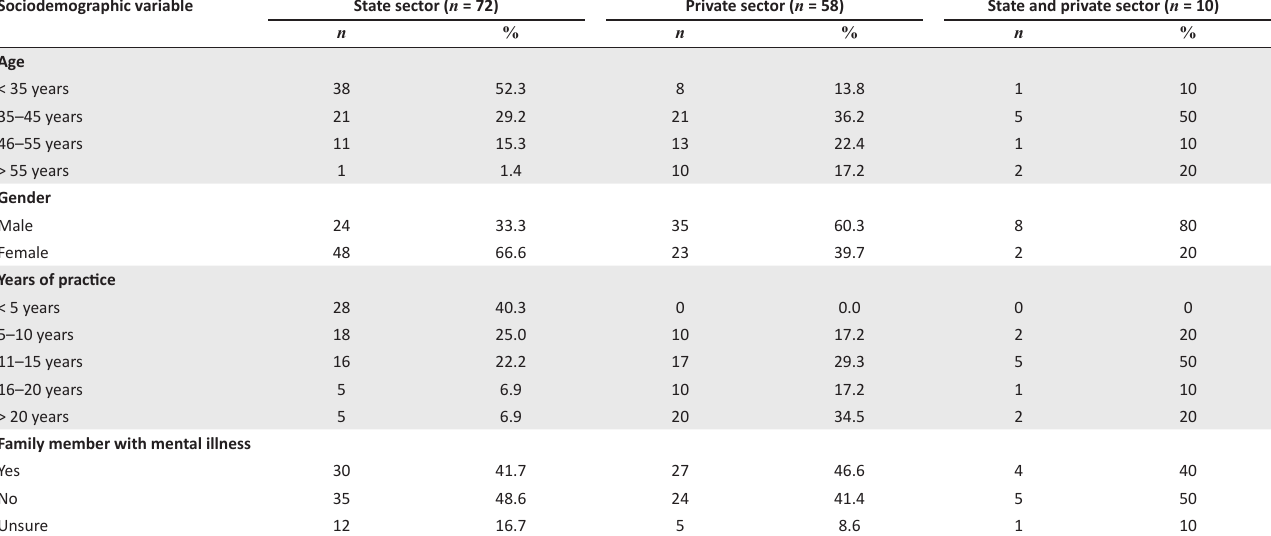
TABLE 1: Frequency distribution of sociodemographic variables of the study population. Sociodemographic